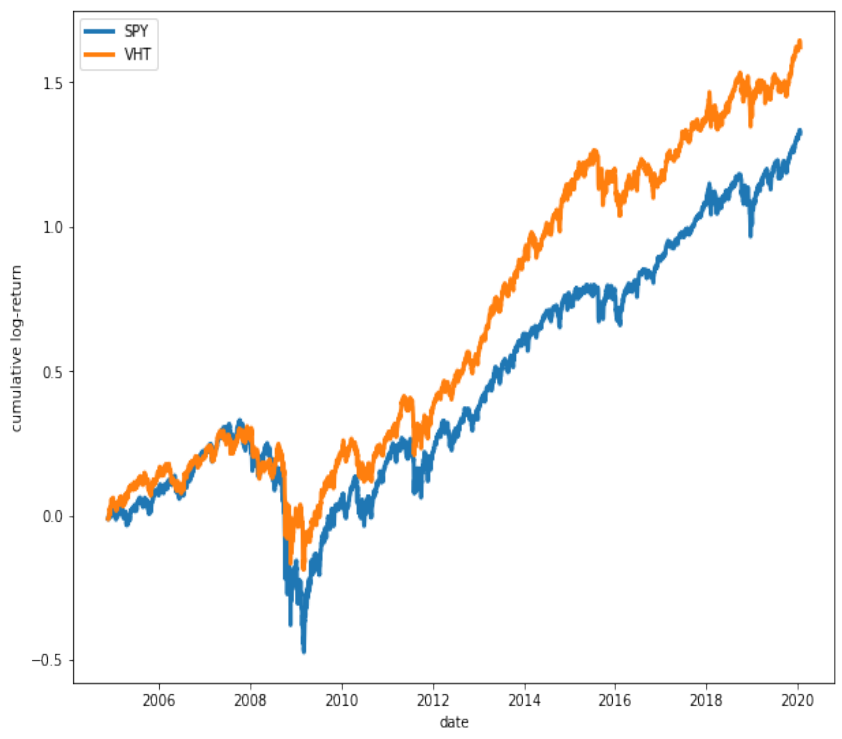
Figure 15. Cumulative log-returns of ETFs SPY and VHT. A high degree of co-movement is observed between the two series ( HP = 0.998).